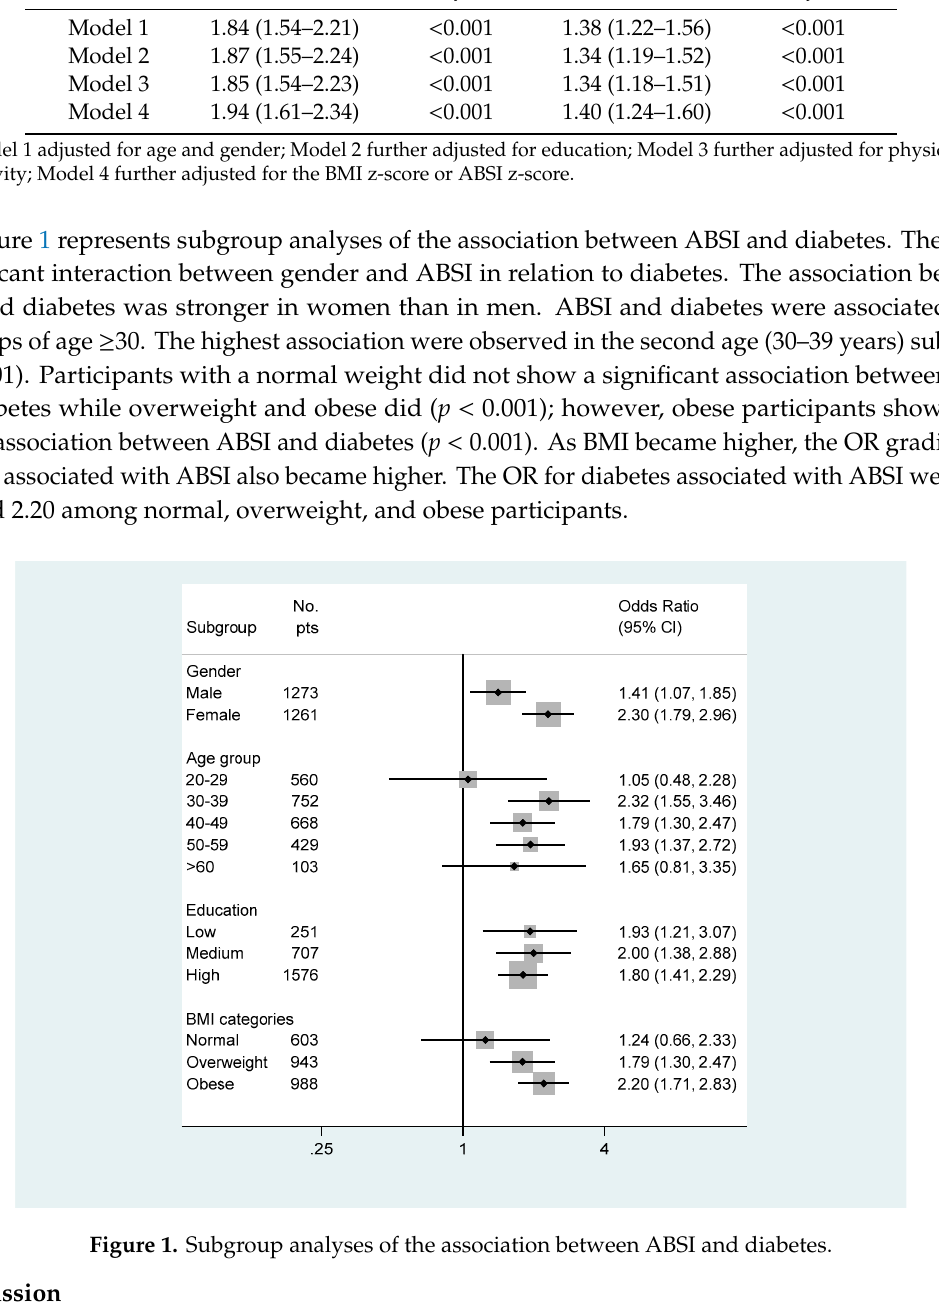
Table 2. The association between A Body Shape Index (ABSI) and BMI with diabetes among Qatari adults.